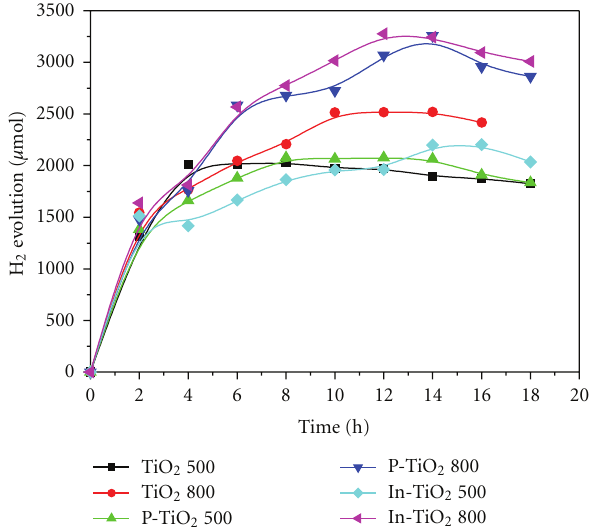
Figure 1: Catalytic activity of 1mol% P, In-TiO 2 , and TiO 2 with rutile and anatase phases during the production of H 2 from methanol/water